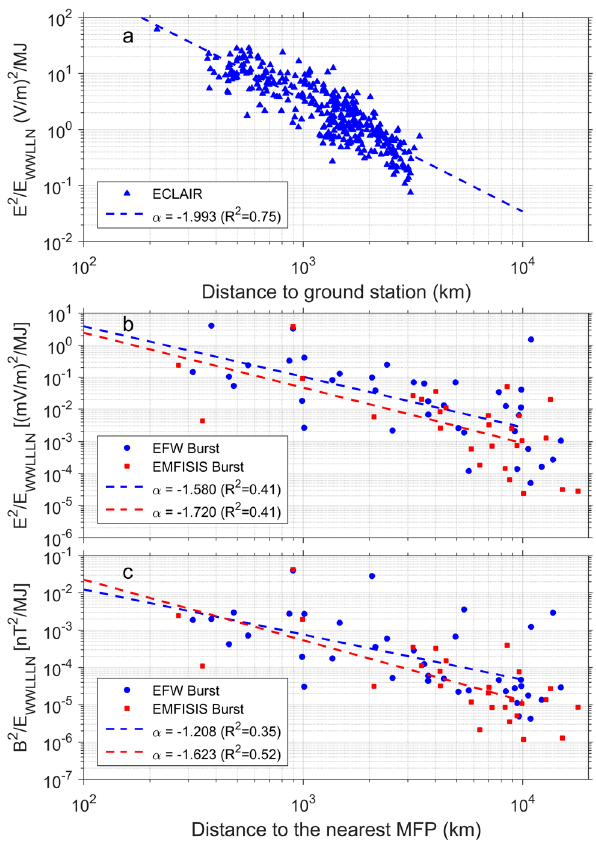
Fig. 4 space and ground-based electric and magnetic power attenuation with distance. a Mean-squared electric fi eld from 2 to 5 MHz of superbolts, averaged over 1.5 ms, and measured on the ground by ECLAIR and MTRG, then scaled by WWLLN stroke energy in MJ, as a function of distance from stroke location to ECLAIR and MTRG detecting stations. b Mean-squared electric fi eld of superbolts in space in the VLF range, averaged over a 1 s duration, scaled by the WWLLN stroke energy, as a function of the distance from stroke location to the nearest magnetic footprint (MFP) of the Van Allen Probes, from (blue circle) EFW burst mode and (red square) EMFISIS burst mode. c Same as middle for the mean-squared magnetic fi eld. Regressions give the decay by power laws (color indicates which type of measurements are